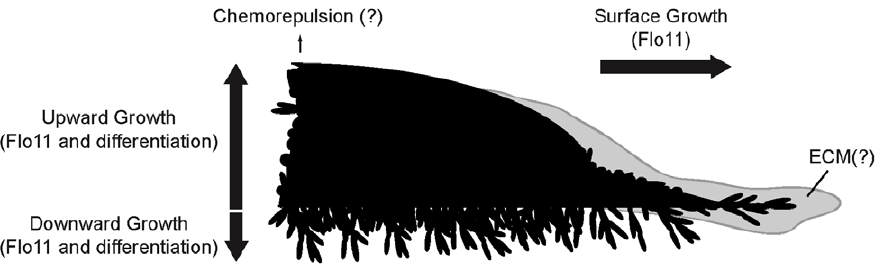
Figure 8. Model for the different mat responses controlled by the MAPK pathway. Schematic of a mat expanding under nutrient-limiting conditions is shown. Different responses regulated by the MAPK pathway may include: 1) mat expansion in the plane of the XY-axis (surface growth, through Flo11 [23]), 2) cell differentiation that causes invasive growth in the Z-axis (downward growth, Flo11 and differentiation), and 3) upward growth in the plane of the Z-axis in response to surface rigidity and nutrient-limiting conditions (Flo11 and differentiation). This upward growth may represent a type of chemorepulsion. An extracellular matrix (ECM), which may contain shed Flo11 [48] as well as other proteins is depicted.